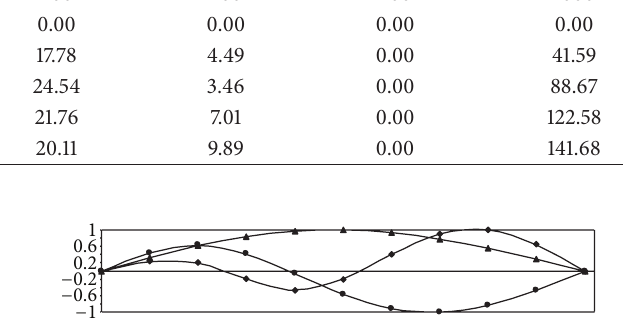
Figure 3: Optimal and target mode shapes (Case